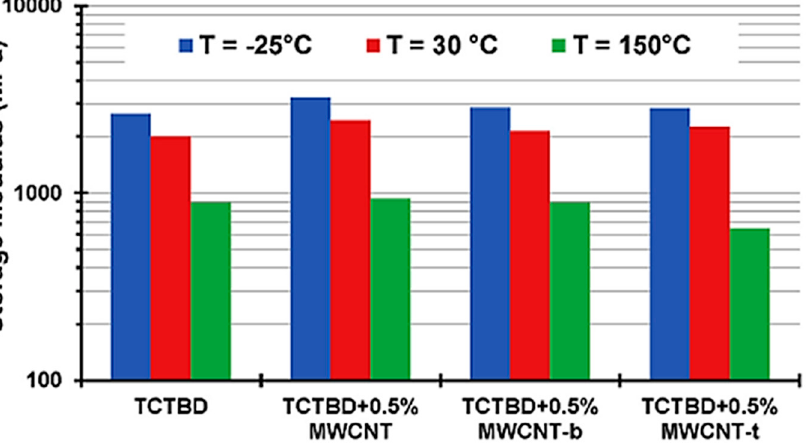
Figure 9. Storage modulus of nanocomposites at three different temperatures TCTBD = tetraglycidyl methylene dianiline modified with carboxyl-terminated butadiene acrylonitrile, 1,4-butanedioldiglycidylether and 4,4 ′ -diaminodiphenyl sulfone; MWCNT = multiwalled carbon nanotube. Reprinted with permission from [112]. 2019, Elsevier (Creative Commons CC-BY).